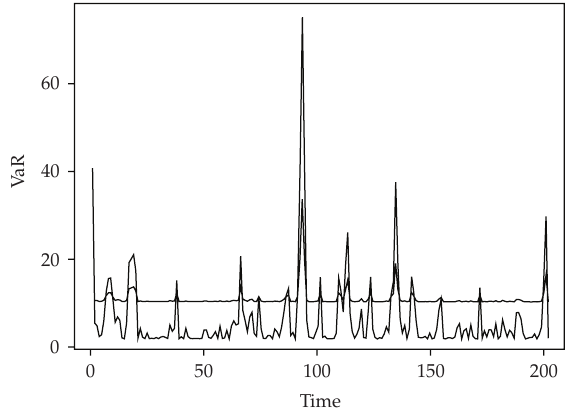
Figure 5: True and ARCH-Based VaR (cid:2) 200 obs (cid:3) .